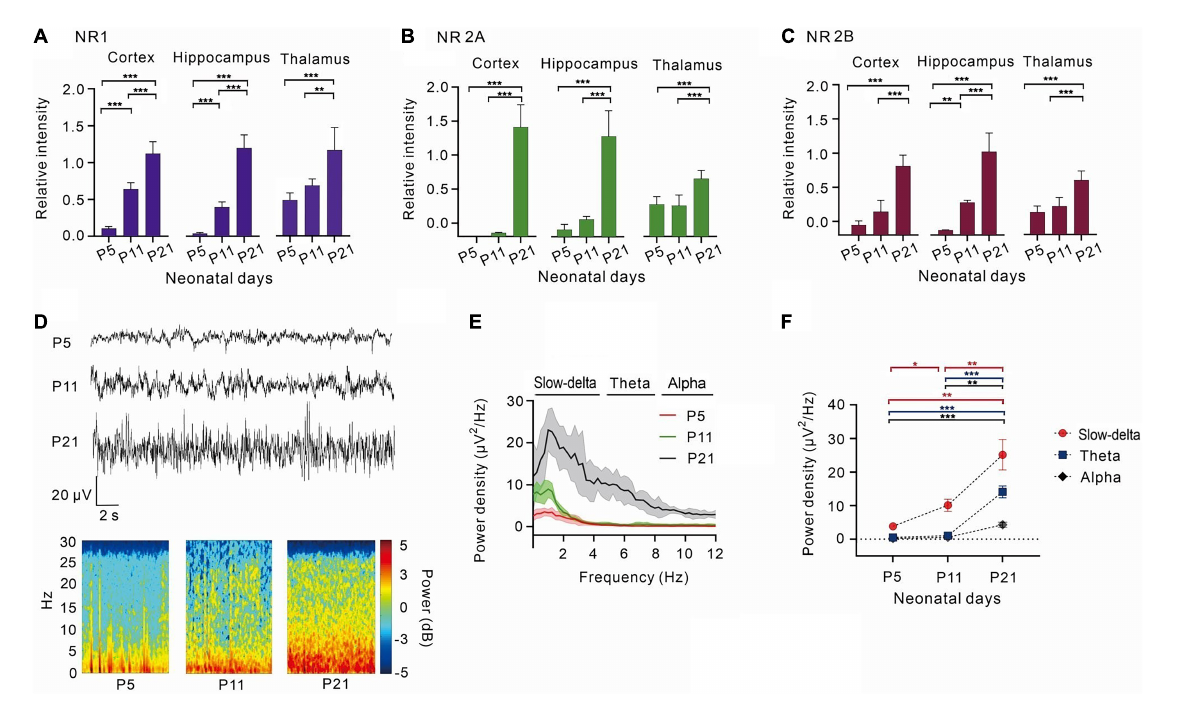
FIGURE1 With the development of the central nervous system, NR1, NR2A, NR2B increased gradually, and the power density of theta oscillations gradually strengthens. (A) The relative expression of NR1 in the cortex ( n = 5), hippocampus ( n = 5), and thalamus ( n = 5). (B) The relative expression of 2A in the cortex ( n = 5), hippocampus ( n = 5), and thalamus ( n = 5). (C) The relative intensity of 2B in the cortex ( n = 5), hippocampus ( n = 5), and thalamus ( n = 5). (D) EEG and it’s power spectrogram of P5, P11, P21 rats in resting state. (E) Power spectral density of cortical EEG at each age ( n = 5). (F) Power density of EEG in different frequency bands from P5 to P21 ( n = 5). Data are presented as mean ± SD. * P < 0.05; ** P < 0.01; *** P < 0.001 by ordinary one-way ANOVA (A–C) , or two-way ANOVA (F)